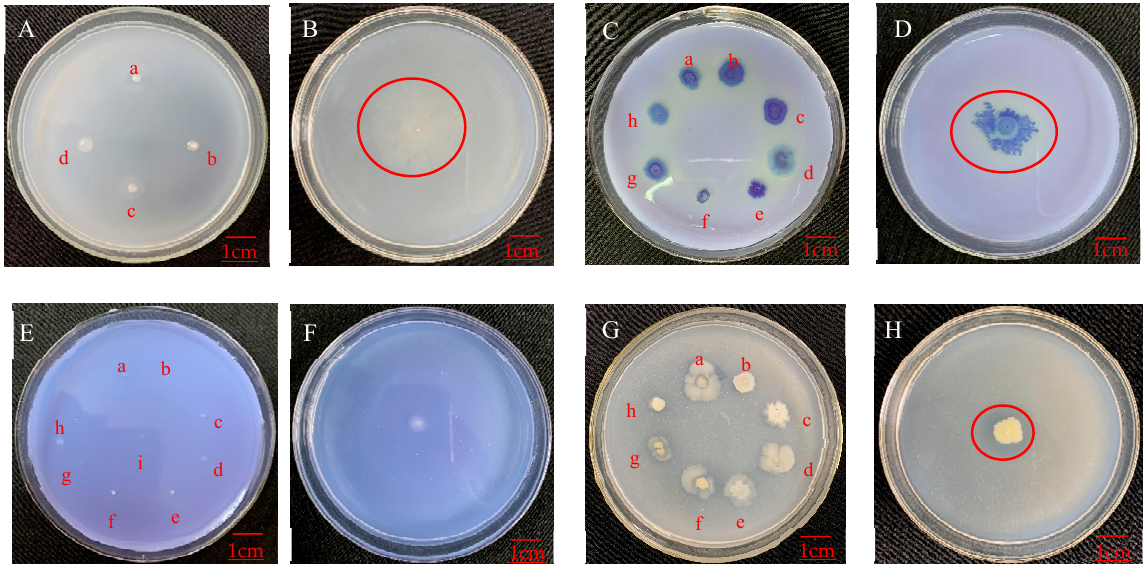
Figure 5. Growth performance of endophytic bacteria on functional media. Ashby